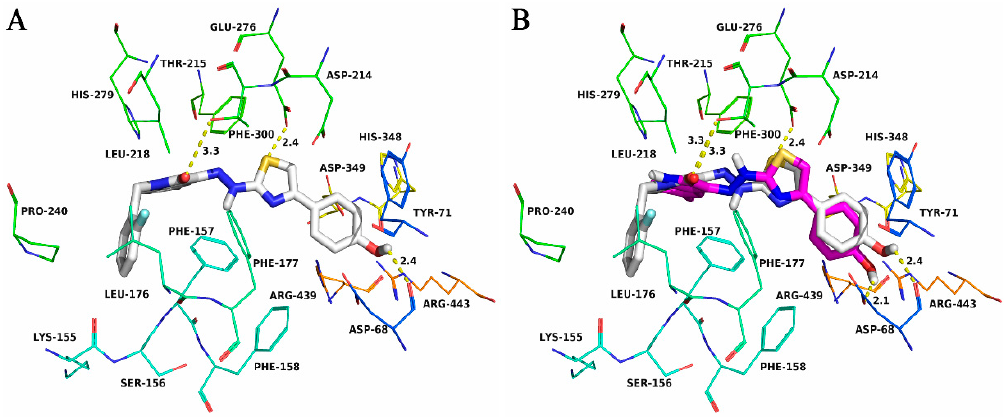
( B ) Compounds 6i and 6p were docked to the binding pocket of the Saccharomyces cerevisiae α - glucosidase glucosidase (overlapped).